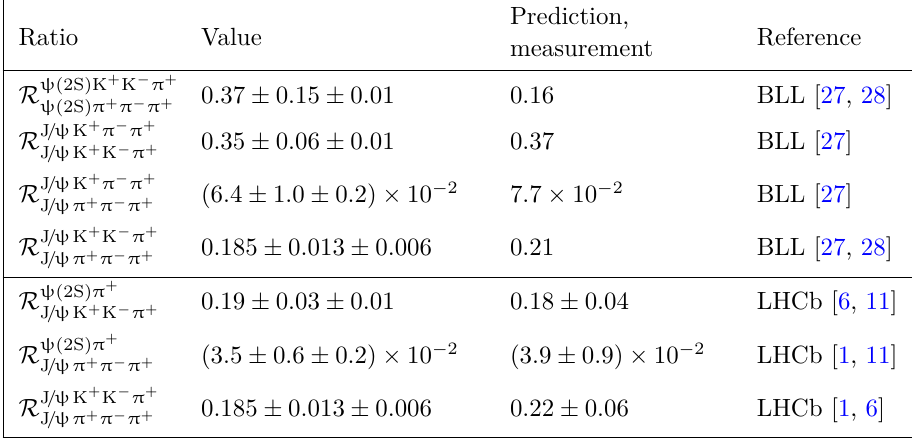
Table 5 . Comparison of the measured ratios R X from previous